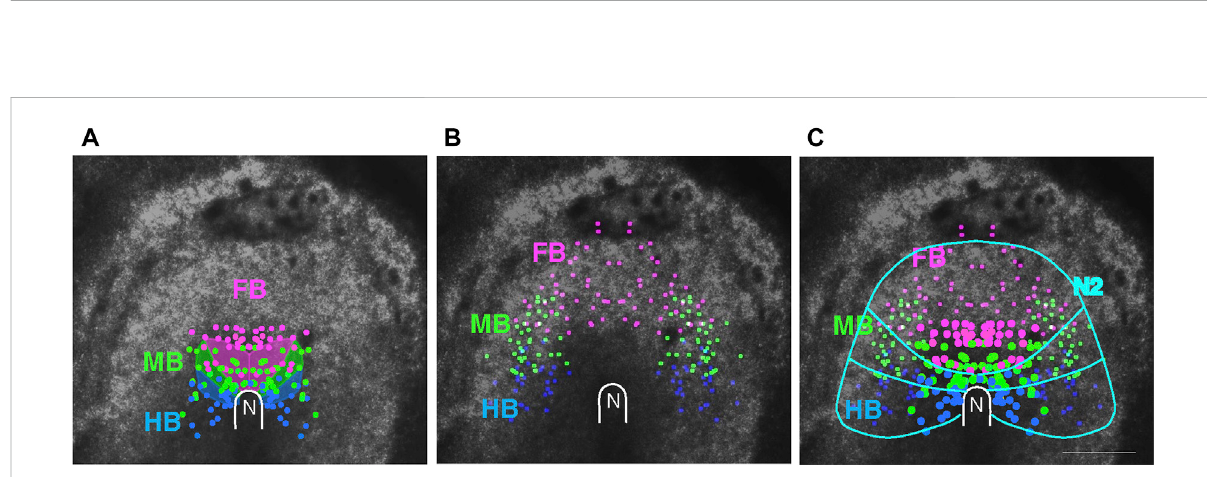
FIGURE 3 Thedistributionofheadtissue precursorsatst.5. (A) Positionsoftheprecursorsfor differentbrainportions, FB,MB,andHB,indicatedbycolor- coded dots, compiled from data of four embryos. The data are compared with the brain portion precursor map by Fernández-Garre et al. (2002), shown as shadedareas. (B) Thedistributionoftheprecursors for thedorsalbrain/headectoderm atst.8/9 inthree embryos, color-codedaccording to the abutting brain portions. (C) Combination of the data in (A,B) , where the larger dots represent brain portion precursors. Approximate boundaries of theabove precursor regions and the outer limit of Sox2 N2 enhancer activity (Figure 1A) are drawn in cyan. N, thenode position. Scale bar, 500 µm. Adopted from Figure 4 of Yoshihi et al.